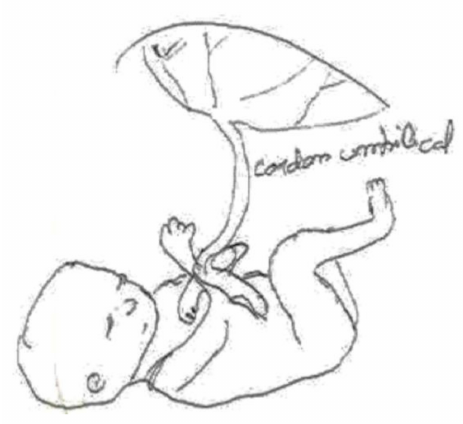
Figure 1. Breastfeeding, secondary education, employed in retail.